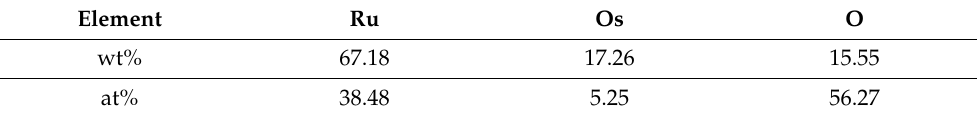
Table 2. Chemical composition of the OsRu electrocatalysts determined by EDS.